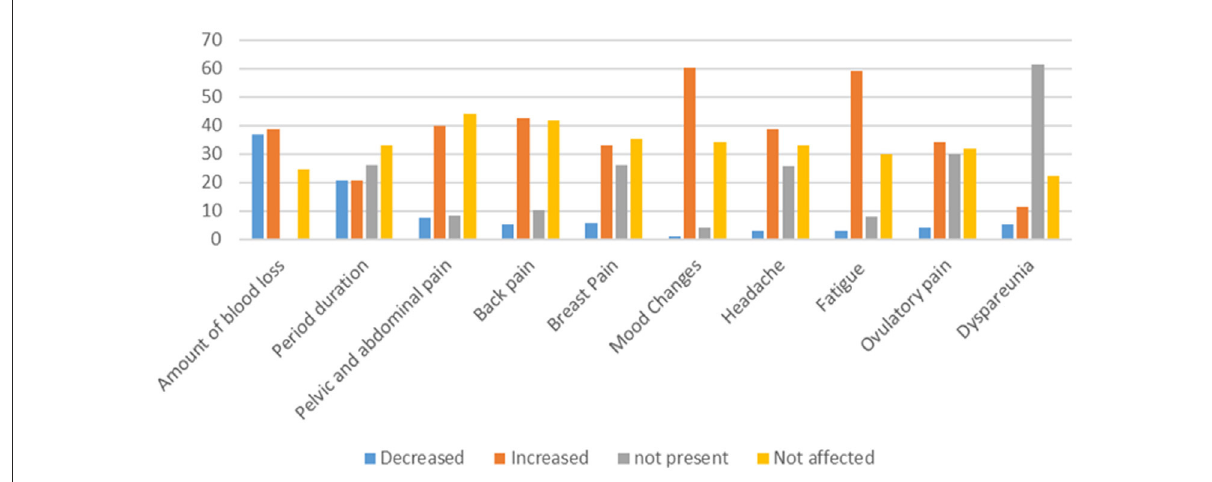
FIGURE2 Changes in the menstrual related symptoms among vaccinated women of CBA against SARS-CoV-2